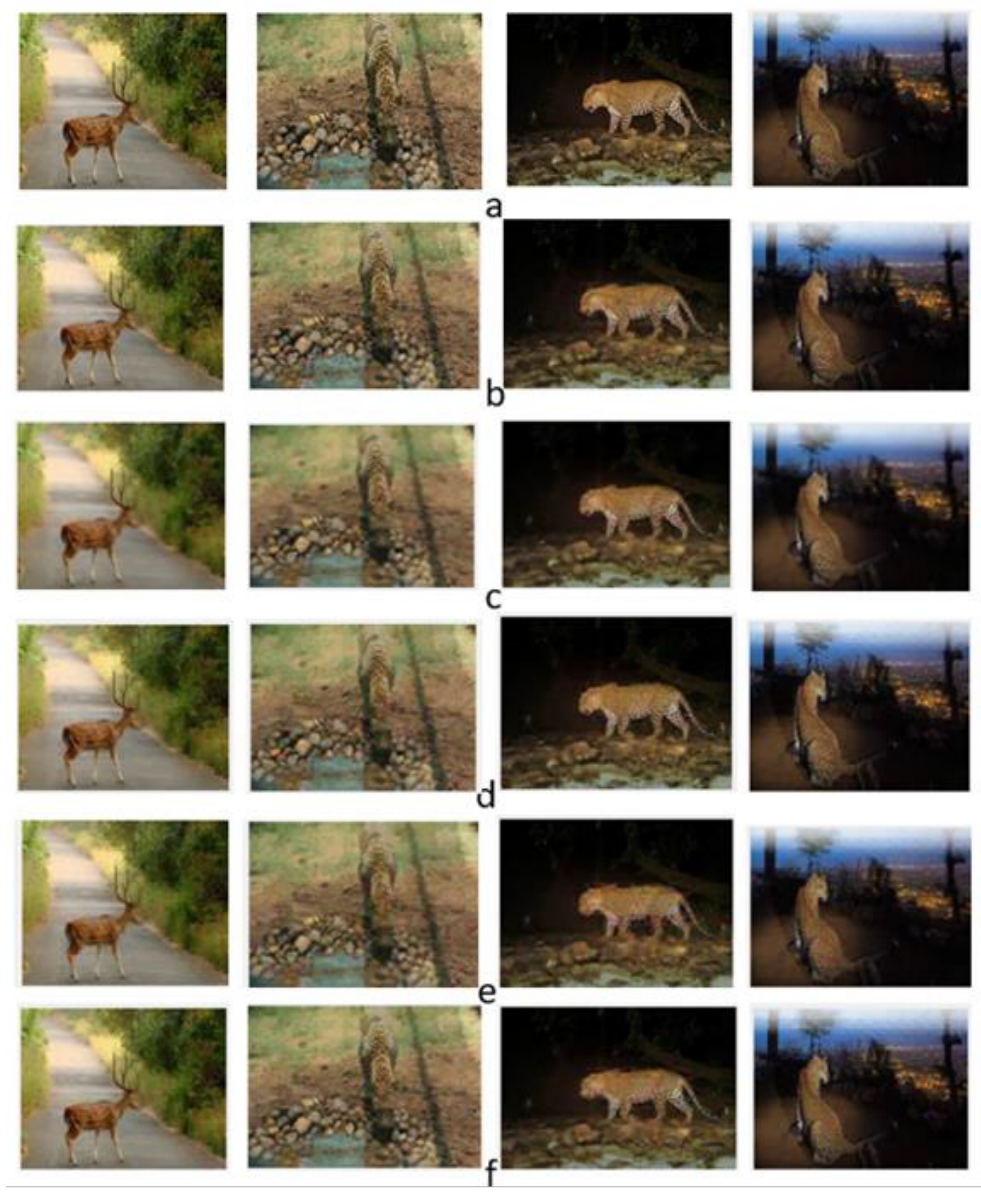
Figure 5. Reconstructed Deer, Leopards images at SR of 0.5 for different methods. ( a ) Original image, ( b ) BCS-SPL, ( c ) STD-BCS-SPL, ( d ) ENT-ABCS, ( e ) EABCS, ( f ) FABCS.